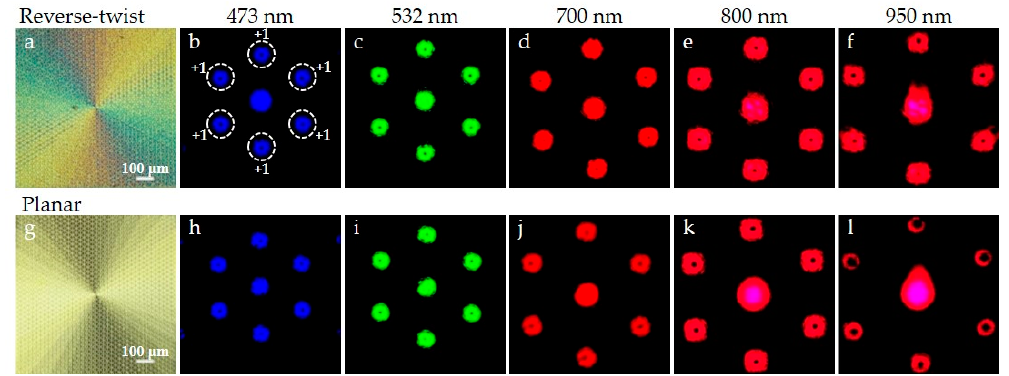
Figure 4. The micrographs of ( a ) double-layer reverse-twist and ( g ) planar hexagonal lattice DQPs under crossed polarizers; ( b – f ) and ( h – l ) the corresponding diffraction patterns at 473, 532, 700, 800, and 950 nm, respectively.